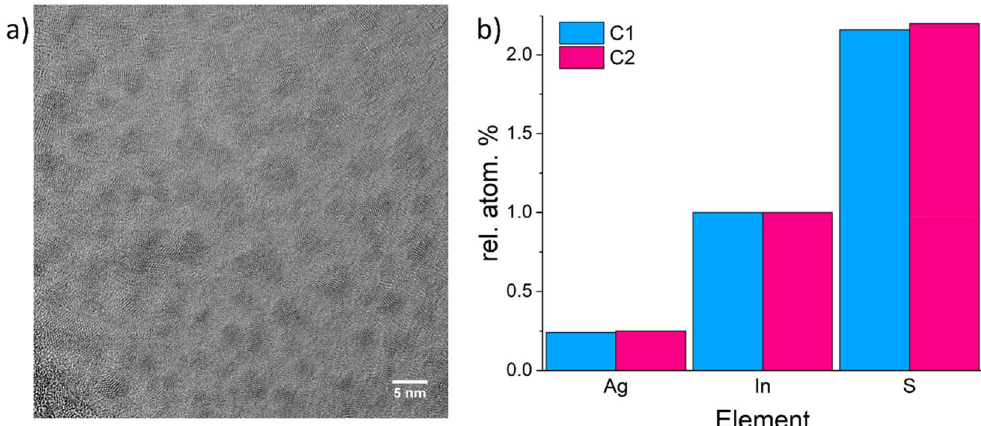
Figure 2. ( a ) TEM image of the AIS-GSH-capped QDs and ( b ) atomic concentration of the different constituting elements obtained by EDX analysis after normalization to the indium (In) concentration of AIS core QDs synthesized with methods C1 and C2